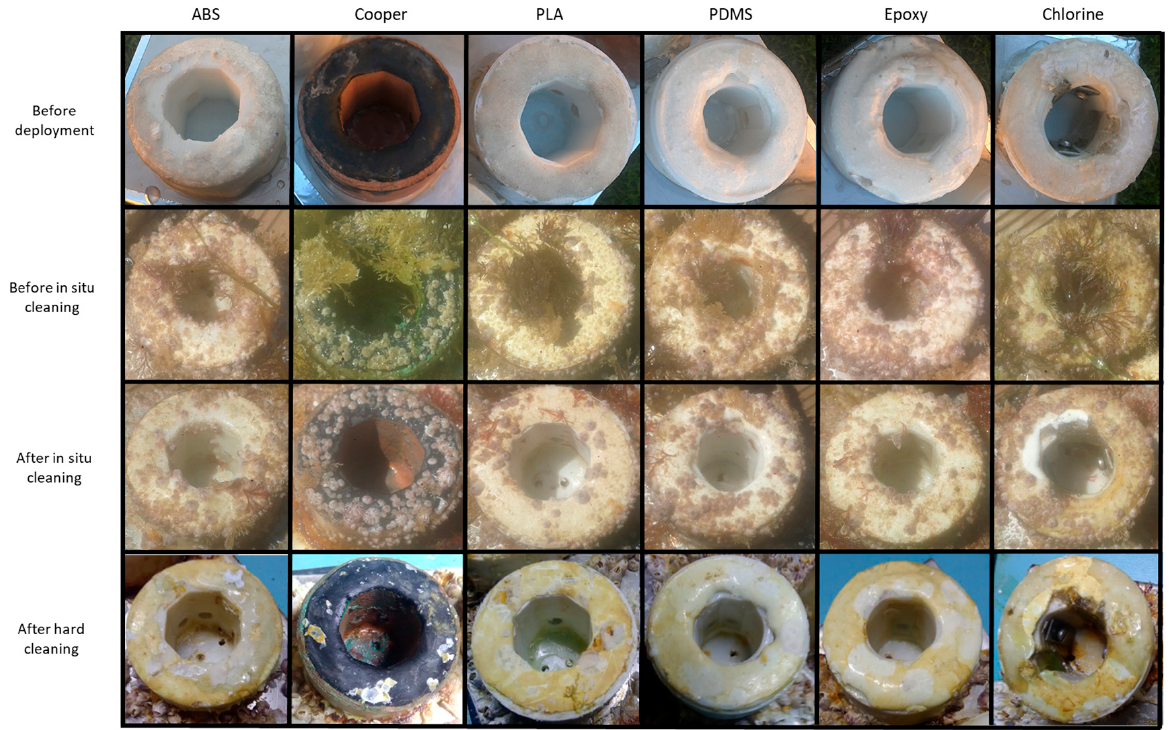
Figure 5. Photographs of the six probes at different stages of the experiment: before deployment, after 46 days of deployment, after the in situ cleaning on the 7 July, and after the hard cleaning at the end of the field test.